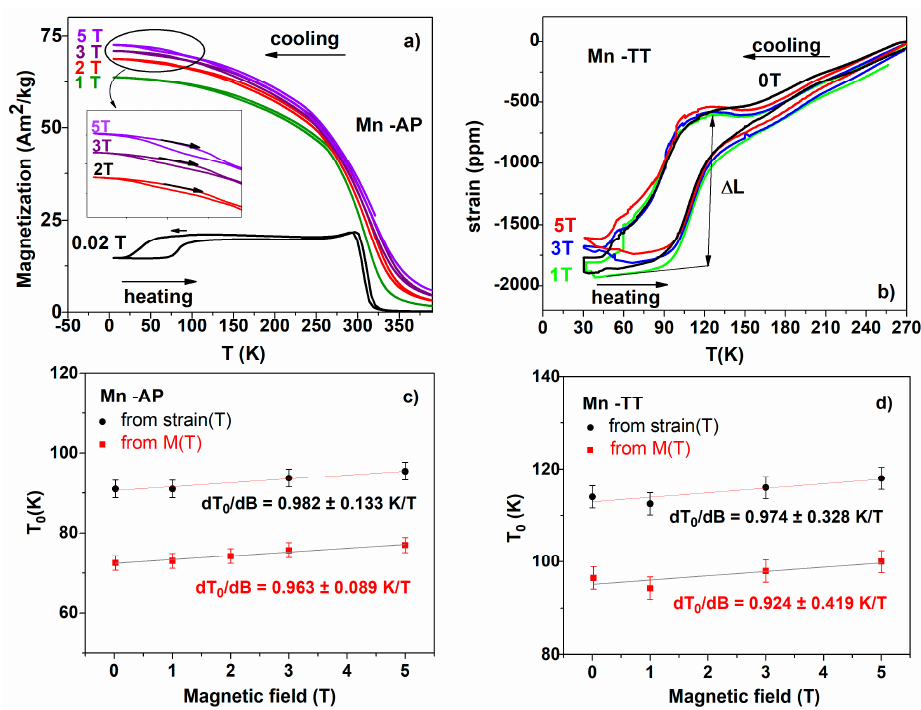
Figure 4. ( a ) Iso-field magnetization curves performed by cooling–heating the ribbons; ( b ) thermo-strain curves recorded at 0, 1, 3 and 5 T applied magnetic field for Mn-TT; ( c ) The T 0 dependences as a function of the applied magnetic field from thermomagnetic and thermo-strain measurements for Mn-AP; ( d ) the same for Mn-TT samples.